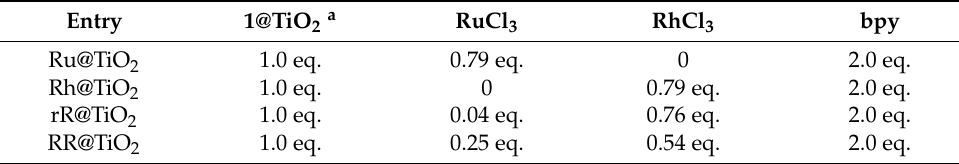
Table 2. Different metal complex functionalized